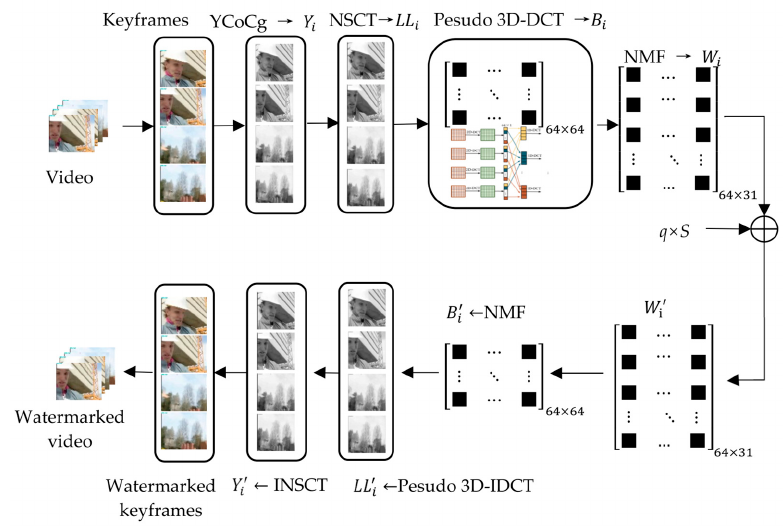
Figure 4. An example of a video watermark embedding algorithm.